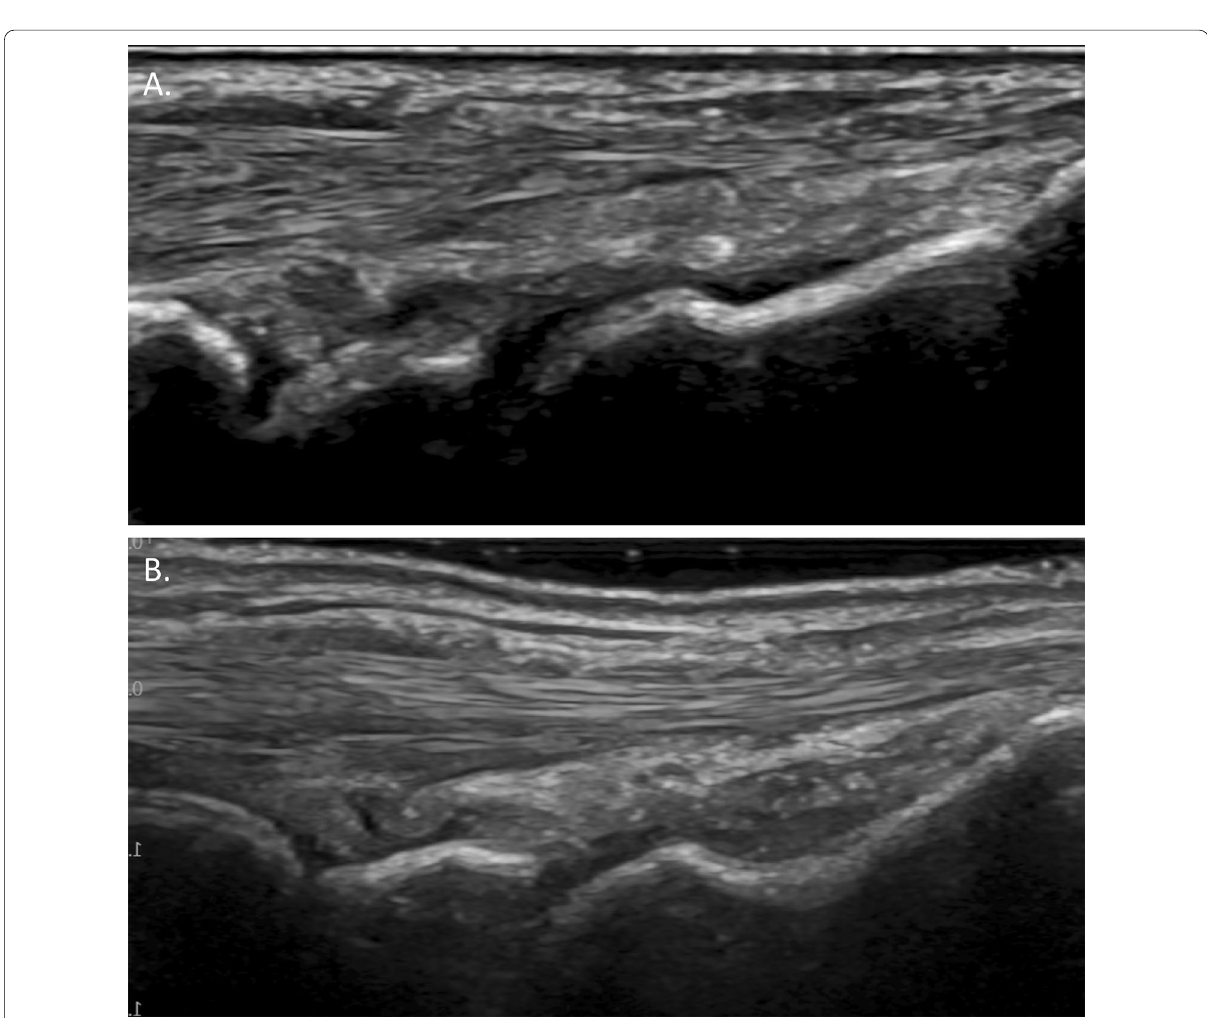
Fig. 2 Representative grey scale ultrasound image of the wrist (radiocarpal and intercarpal joint) from the same patient by respectively ARTHUR ( A ) and the rheumatologist ( B